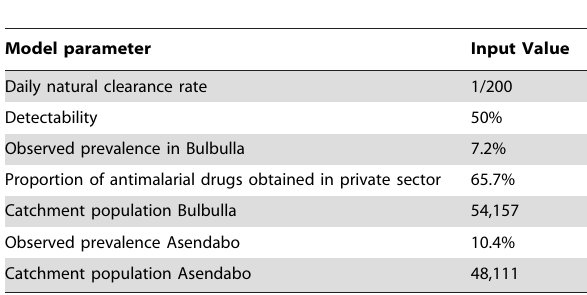
Table 2. Other parameter